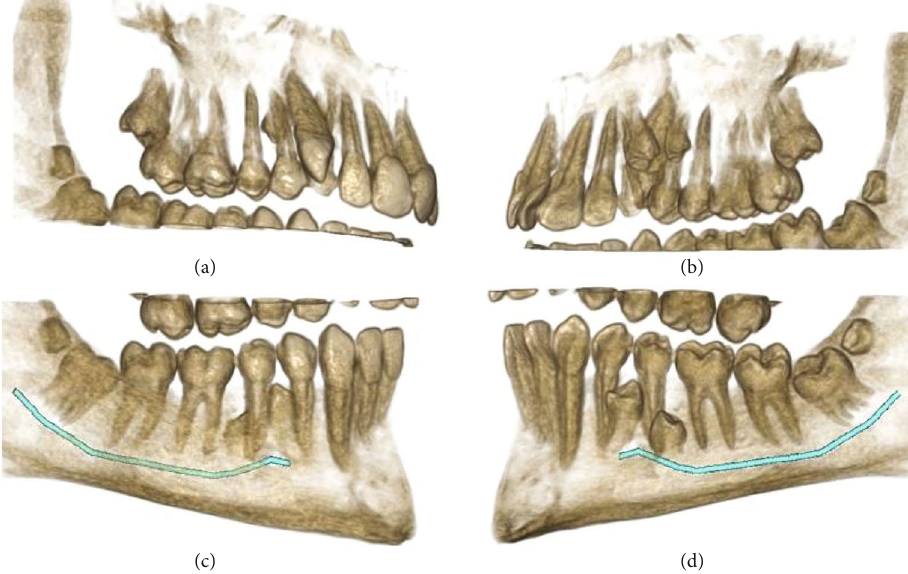
Figure 9: 3D reconstructions of the right upper and lower quadrants. (a, c) The buccal view (with slight adjustments in the point of view). (b, d) The palatal view. The mandibular nerve canal is highlighted.